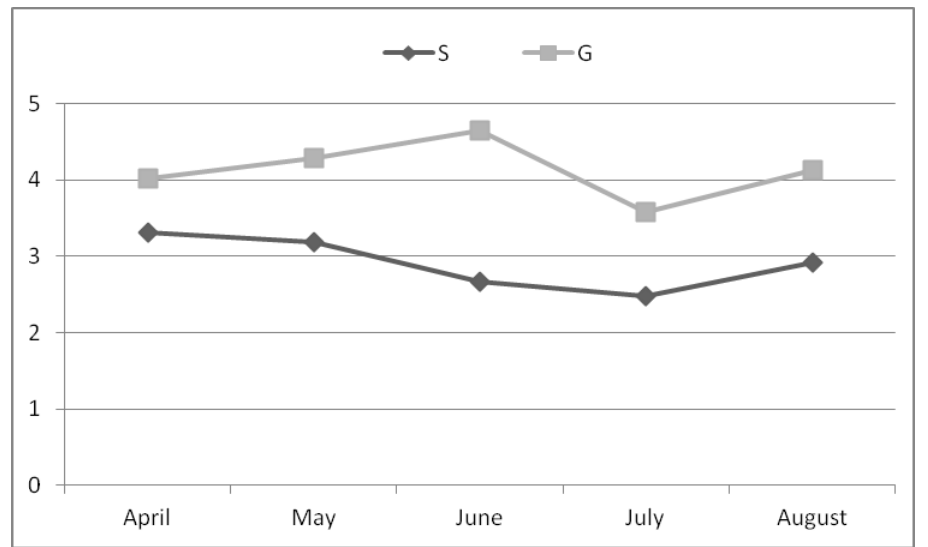
Figure 1. Milk fat (%) along the trial.